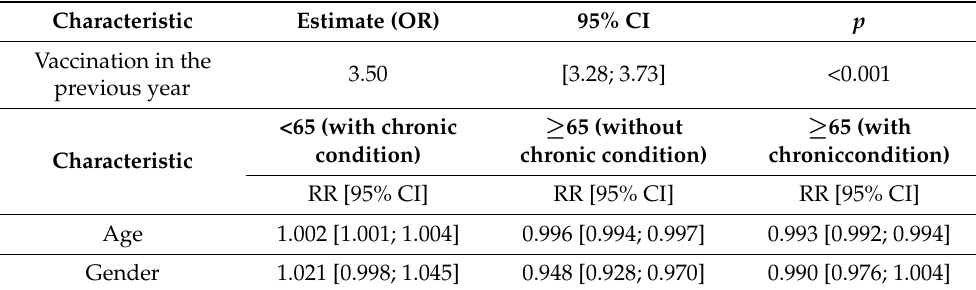
Table 4. Factors associated with increased